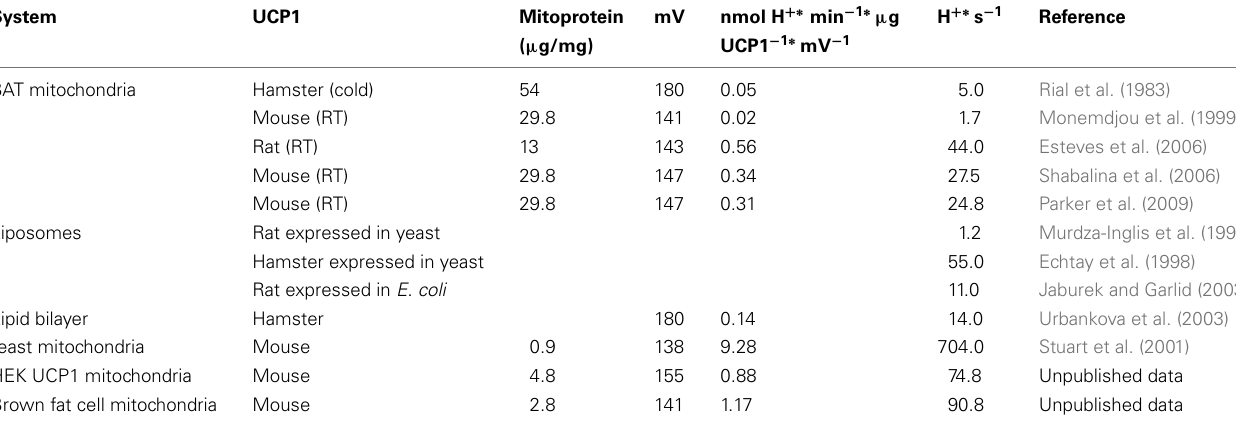
Table 1 | Comparison of maximum UCP1-dependent H + transport rates in different test